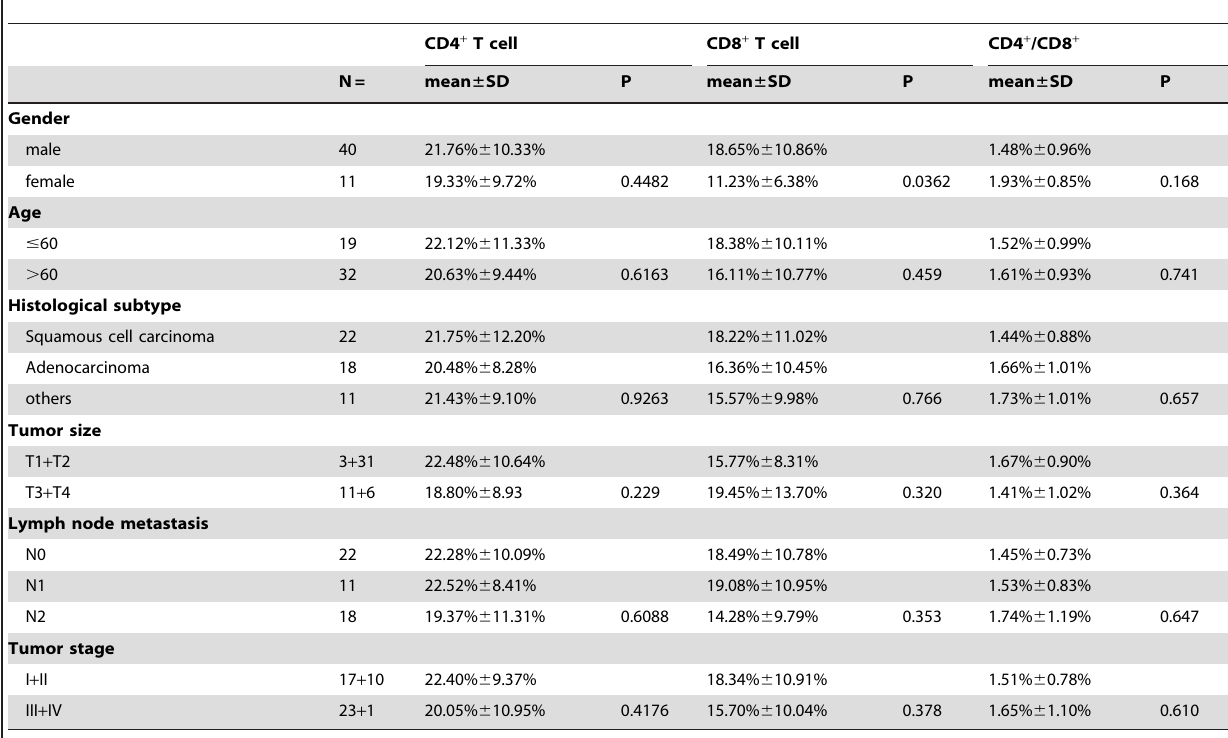
Table 1. The percentage of CD4 + , CD8 + T cell in TILs in patients with NSCLC.